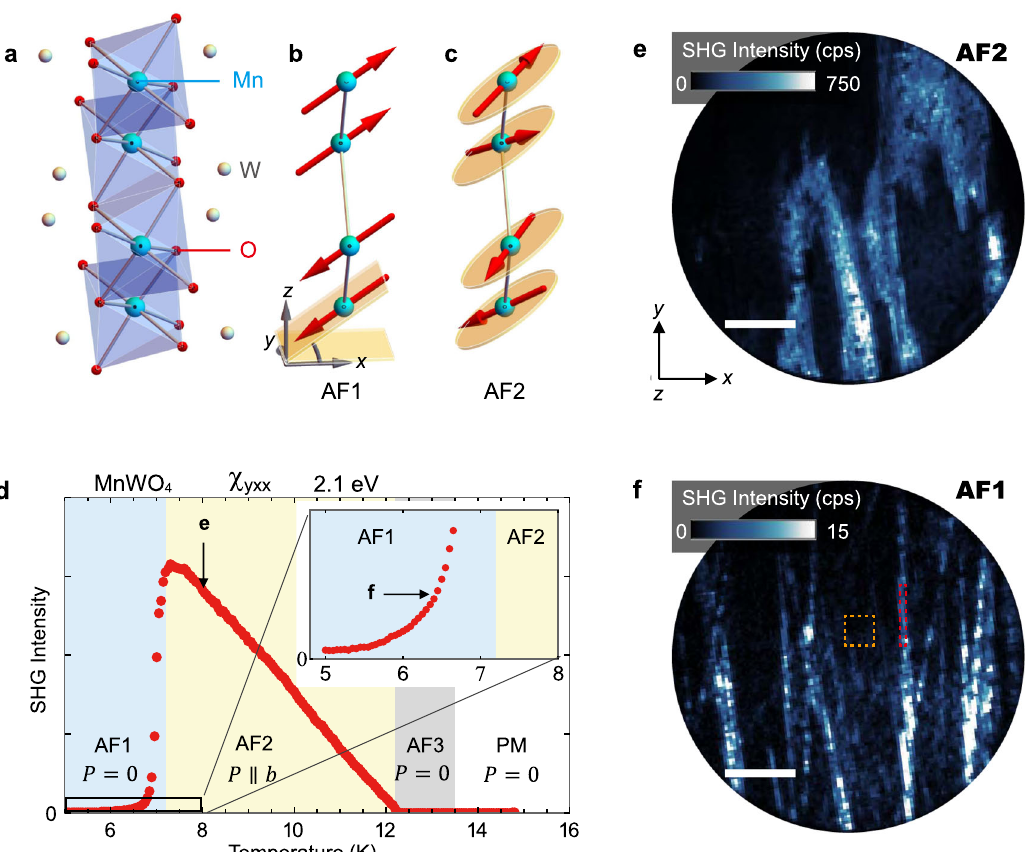
Fig. 1 Temperature dependence of second harmonic generation. a Crystal Structure of MnWO 4 . b , c Magnetic structures in the b AF1 and c AF2 phases, respectively. The red arrows represent the magnetic moments of the Mn 2 + ions and yellow circles show the spin-spiral plane. d Temperature dependence of the SHG for the tensor component χ yxx at the photon energy 2 _ ω ¼ 2 : 1 eV. The inset shows the enlarged view of the SHG intensity in the SHG-forbidden AF1 phase. e The SHG image was obtained at 8 K in the multiferroic AF2 phase after the zero- fi eld cooling. f The SHG image was obtained at 6.5 K in the non-multiferroic AF1 phase. The orange and red regions indicate the regions which are used for the polarization dependence measurements in Fig. 2d. Scale bars, 200 μ